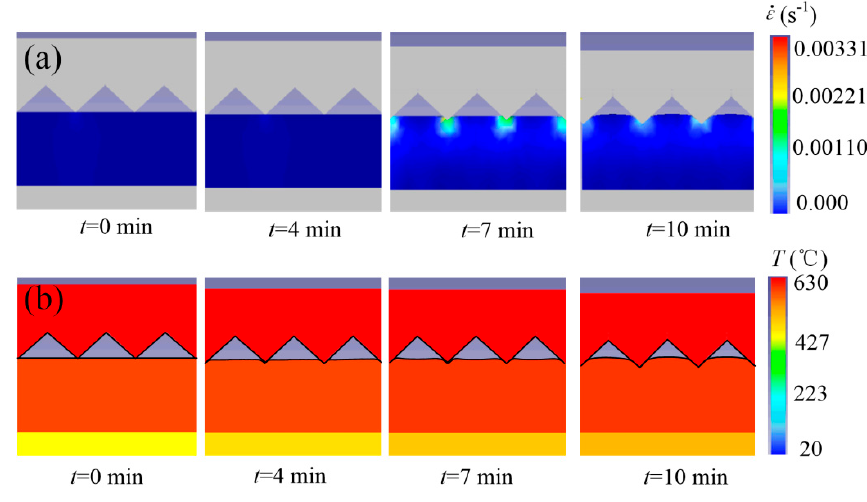
Figure 6. ( a ) Strain-rate and ( b ) deformation changes of microforming glass substrate.